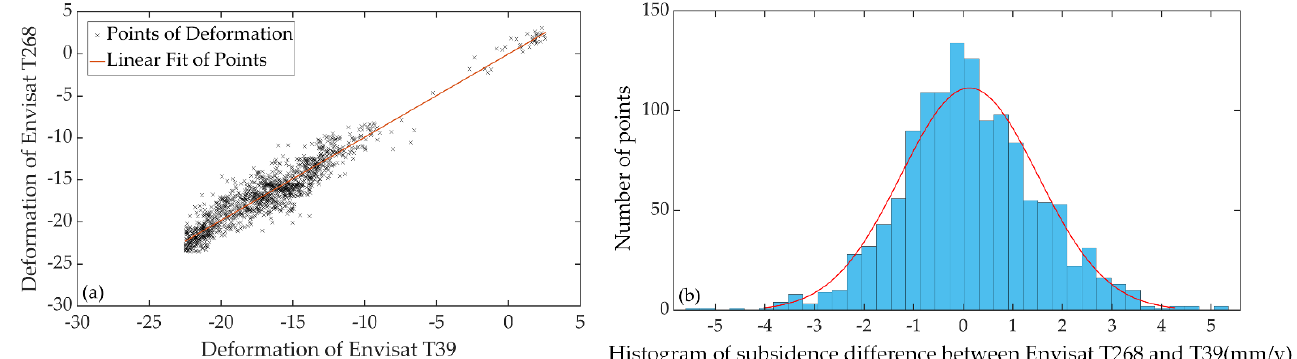
Figure 7. Internal accuracy verification. ( a ) Scatter plot and linear fit of deformation rate for the two sets of results, and ( b ) difference between the two sets of results in the vertical direction.